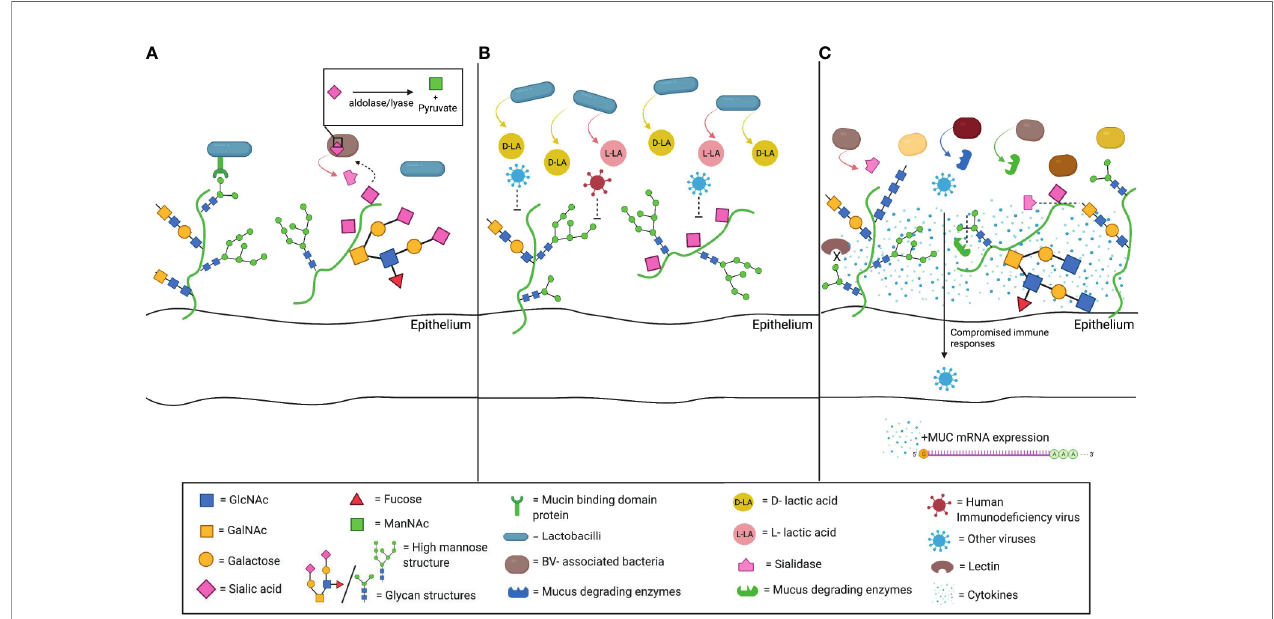
FIGURE 1 | Schematic depiction of interactions between cervicovaginal mucus (CVM) and microbiota. (A) CVM may drive the composition of the commensal vaginal microbial community. Mucin binding protein (MucBP) domains and other binding factors allowing adhesion to mucins have been found on several lactobacilli, including the common vaginal species L. crispatus and L. gasseri . In addition, mucus constituents can be used as nutrient sources by commensal bacteria. Sialidase producing bacteria are able to catabolize the sialic acid present on mucins through an internal aldolase/lyase reaction. (B) Bene fi cial microbes, such as L. crispatus , also drive functional changes in the CVM. L . crispatus produces both D-lactic acid (D-LA) and L-LA, and CVM from women with L. crispatus -dominance has been associated with increased entrapment of viruses, including human immunode fi ciency virus (HIV). (C) Bacterial vaginosis (BV)- associated bacteria can alter CVM properties. They may express sialidase and other mucus degrading enzymes, such as mucinases or other galactosidases. Sialidase production is associated with many of the adverse health outcomes related with BV, such as preterm birth, intrauterine infection during pregnancy, or invading infection. The lower sialic acid and the high mannose abundance, that have been correlated with BV-associated bacteria populations, along with the associated impaired lectin binding further compromise that innate immune responses in the lower genital tract. The resulting in fl ammatory environment has been shown to increased mucin mRNA expression and abundance (Figure created with